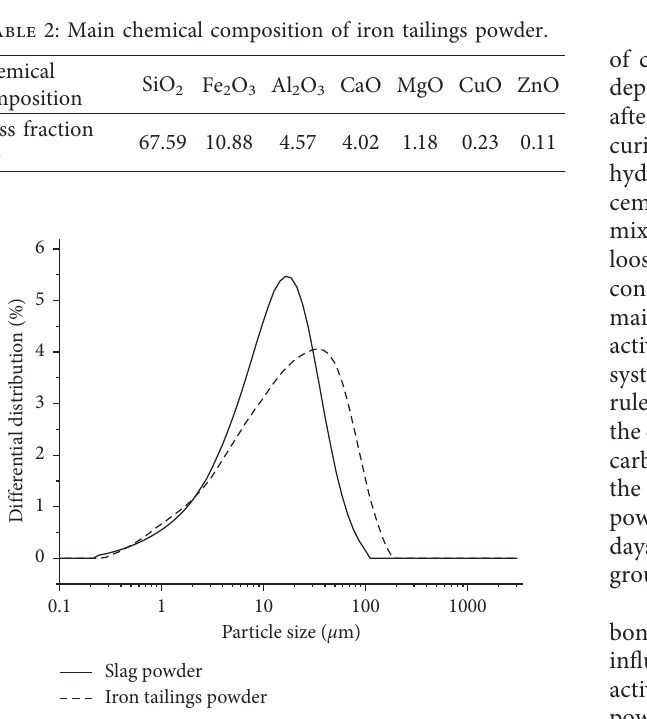
Figure 1: Particle size distribution of iron tailings powder and slag